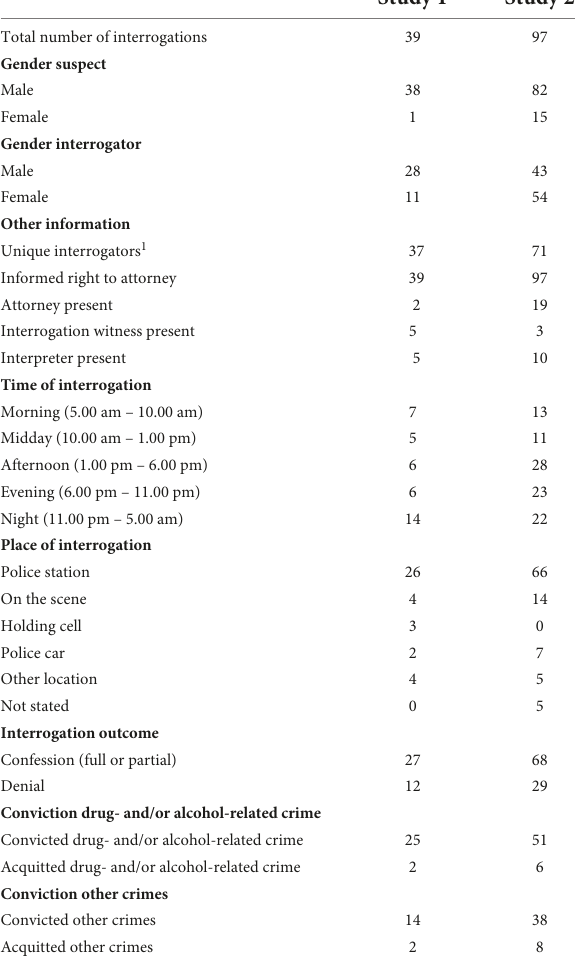
TABLE 2 Characteristics of the interrogation sample in Study 1 and Study